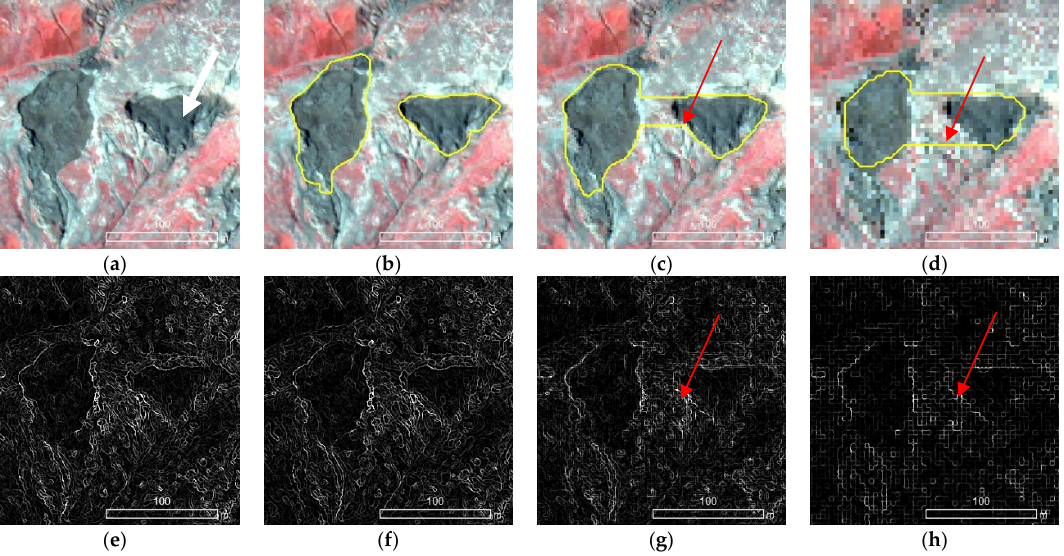
Figure 20. Exampled zoomed-in views ( a – d ) showing the effect of image resizing (spatial resolution degradation) on model predictions. Canny edge images of corresponding original and resized images are shown in ( e – h ). White arrows indicate the location of RTS. Underlying imagery is at 0.5 m resolution with false color composite. ( a ) Original image at 0.5 m resolution. ( b ) Resized image at 1 m resolution (1024 × 1024). ( c ) Resized image at 2 m resolution (512 × 512). ( d ) Resized image at 4 m resolution (256 × 256). ( e ) Canny edge raster at 0.5 m resolution. ( f ) Canny edge raster at 0.5 m resolution. ( g ) Canny edge raster at 2 m resolution. ( h ) Canny edge raster at 4 m resolution.